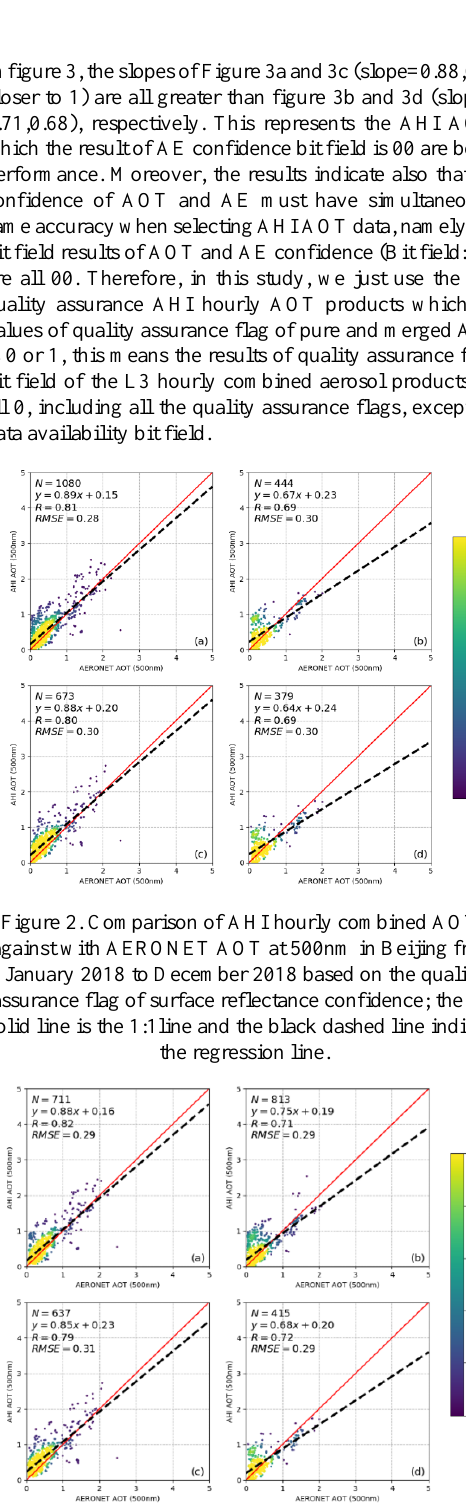
Figure 3. scatter density plots comparing AHI hourly combined AOTs against with AERONET AOTs at 500nm in Beijing from January 2018 to December 2018 based on the quality assurance flag of Angstrom